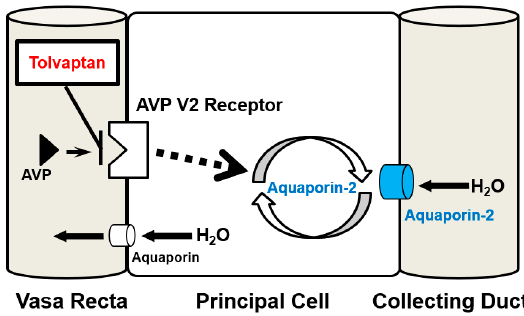
Figure 1. The relationship between arginine vasopressin, aquaporin-2, and tolvaptan in the collecting duct. AVP, arginine vasopressin.